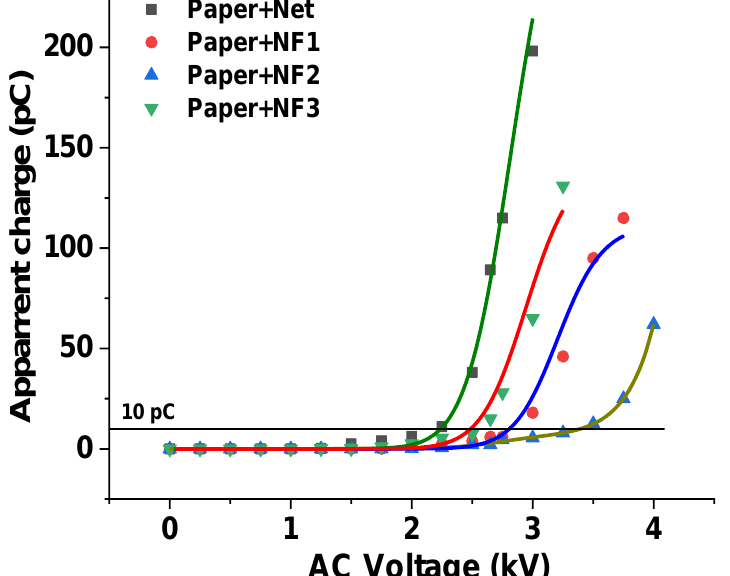
Figure 9. Apparent charge versus the applied AC voltage for the insulating paper impregnated with the Net and NF samples.